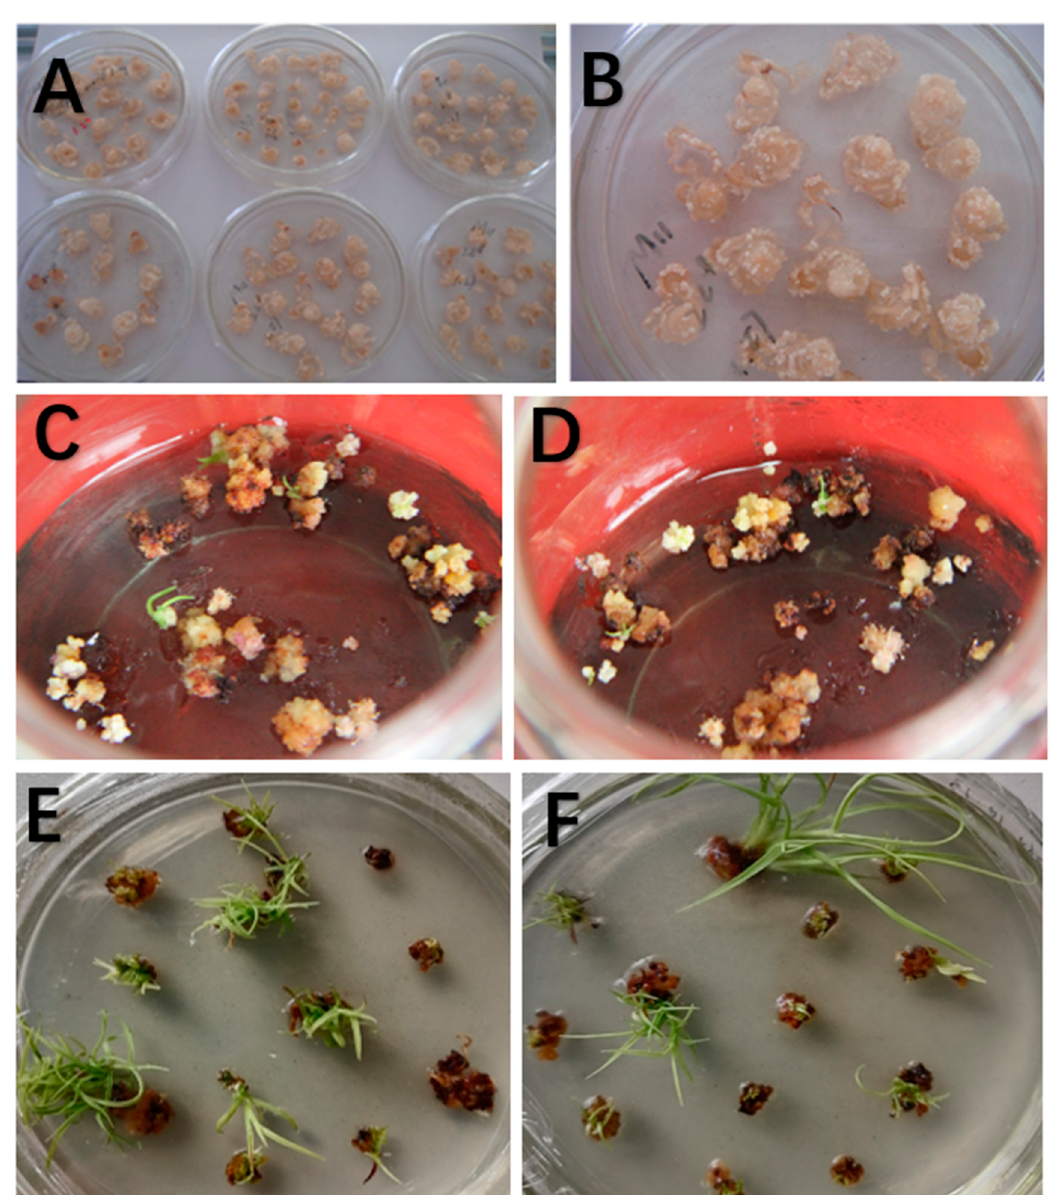
Figure 1. Agrobacterium-mediated genetic transformation of sugarcane. ( A , B ) Induction and culture of embryogenic callus from sugarcane; ( C – F ) differentiation of herbicide-resistant embryogenic callus and herbicide-resistant seedlings PCR detection and screening results showed that all 15 PCAMBIA3301-SCD27 sense lines and 12 PCAMBIA3301-ScD27 antisense lines were positive for the BAR gene, and 13 and 10 lines were positive for ScD27.2 genes, respectively (Figures 2 and 3, Table 1). DNA sequencing con fi rmed the PCR product to be the desired fragment of the Bar and ScD27.2 gene.